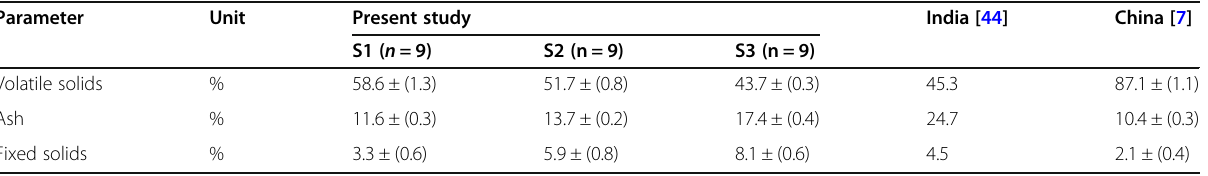
Table 3 Proximate analysis of the aged waste recovered from landfills Parameter